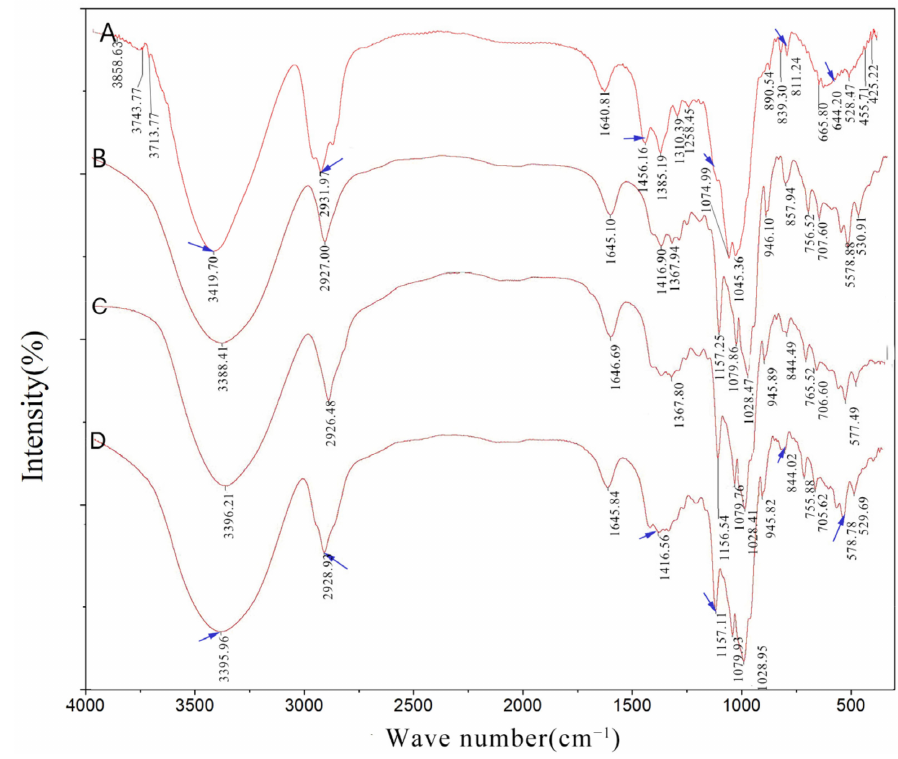
Figure 4. FR-IR spectra of G-Re ( A ), γ -CD ( B ), G-Re- γ -CD PM ( C ), and G-Re- γ -CD IC ( D